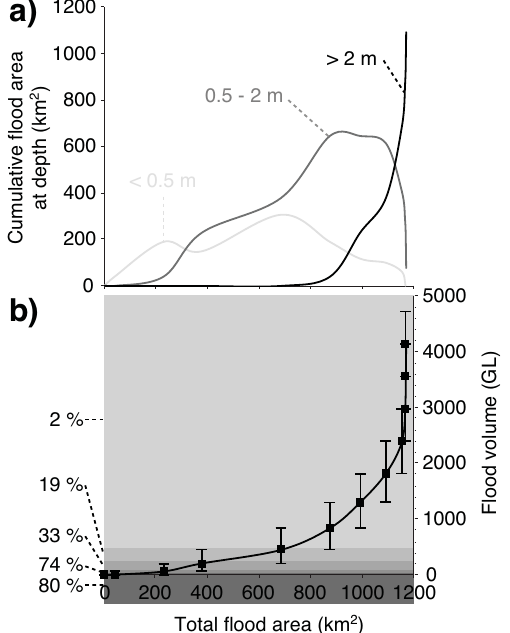
Figure 8. Total flood area at the Fortescue Marsh and (a) its pro- portion occupied by water depth shallower than 0.5m (light grey), between 0.5 and 2m (dark grey) and deeper than 2m (black) and (b) the volume of surface water (black line) with century frequen- cies (%yr) at which different thresholds (grey shading) were at-